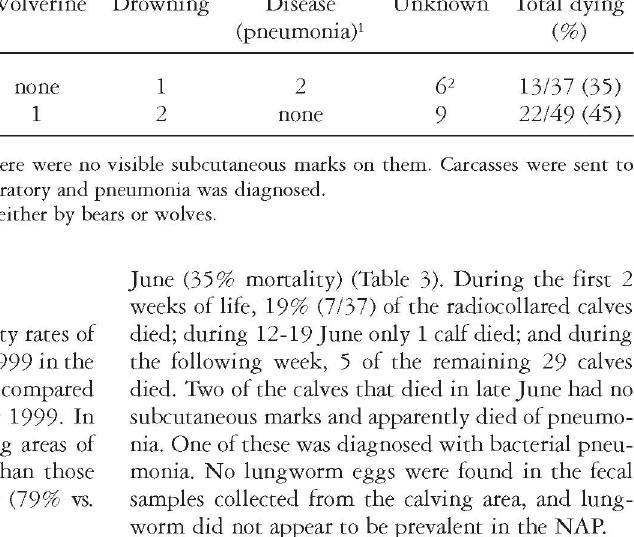
Table 3- Causes and timing of mortality of caribou calves that were radiocollared as newborns in the Northern Alaska Peninsula (NAP) and Southern Alaska Peninsula (SAP) herds in 1998 and 1999 respectively Number of calves collared as newborns that died through 28 June Herd